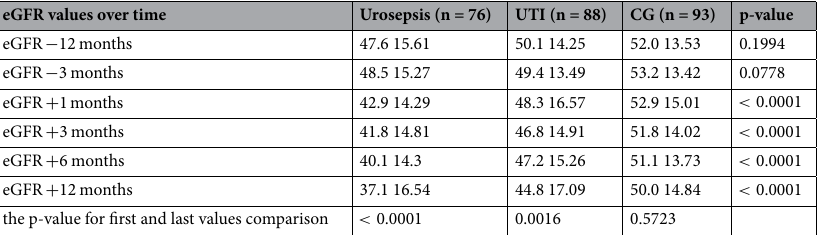
Table 5. Calculated eGFR values (MDRD-4) in the study groups over time.